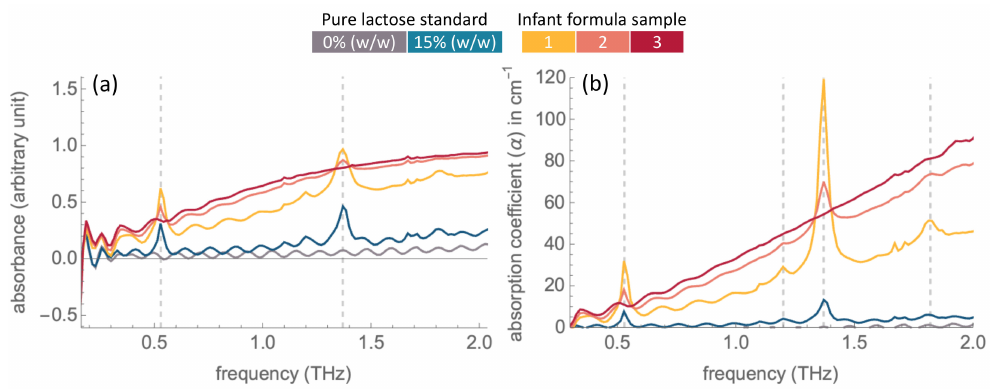
Figure 4. THz ( a ) absorption and ( b ) absorption coefficient spectra of infant formula samples, 15% ( w / w ) lactose and 0% ( w / w ) lactose standard samples.